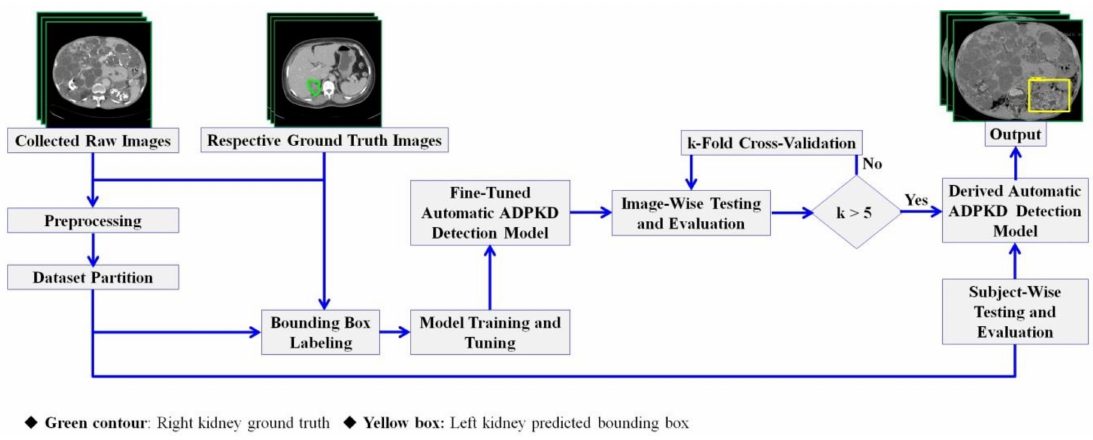
Figure 3. Proposed automatic ADPKD detection model